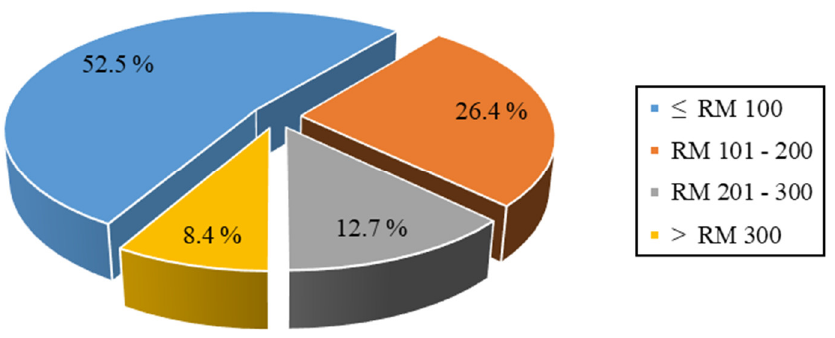
Figure 2. Total out-of-pocket expenditure for seeking of care during past six months; RM, Malaysian Ringgit.